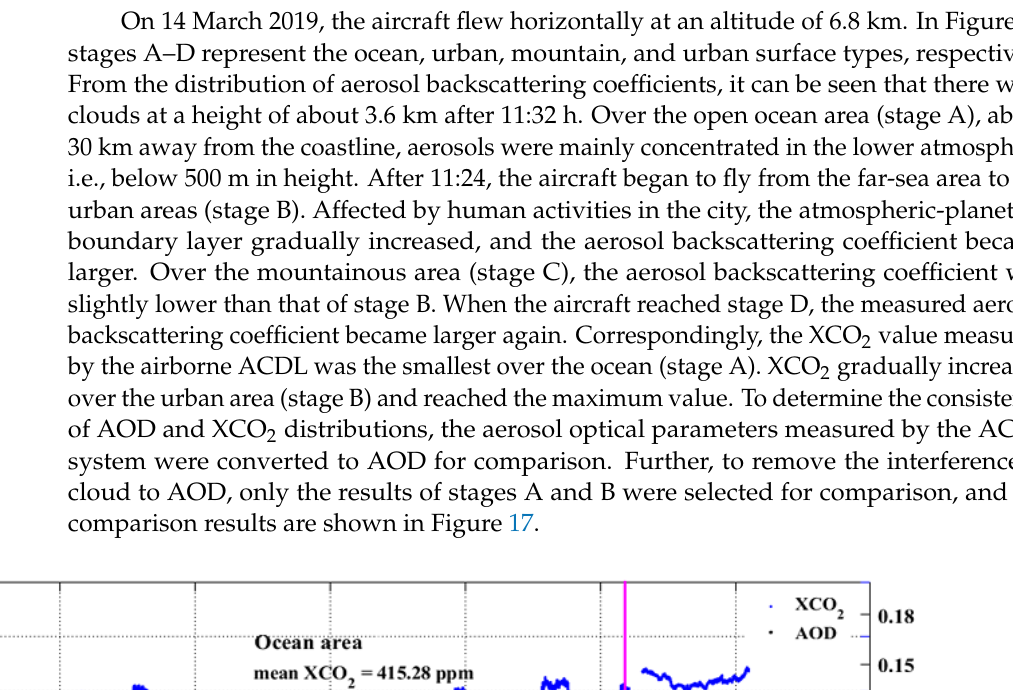
Figure 16. Aerosol backscatter coefficient and XCO 2 results measured by the airborne ACDL system on 14 March 2019. The flight altitude of the aircraft is represented by a solid white line, and the green scattered points are the inversion results of XCO 2 . The flight process is divided into ABCD four parts, corresponding to different surface types. The purple vertical line is the dividing line between different surface types.